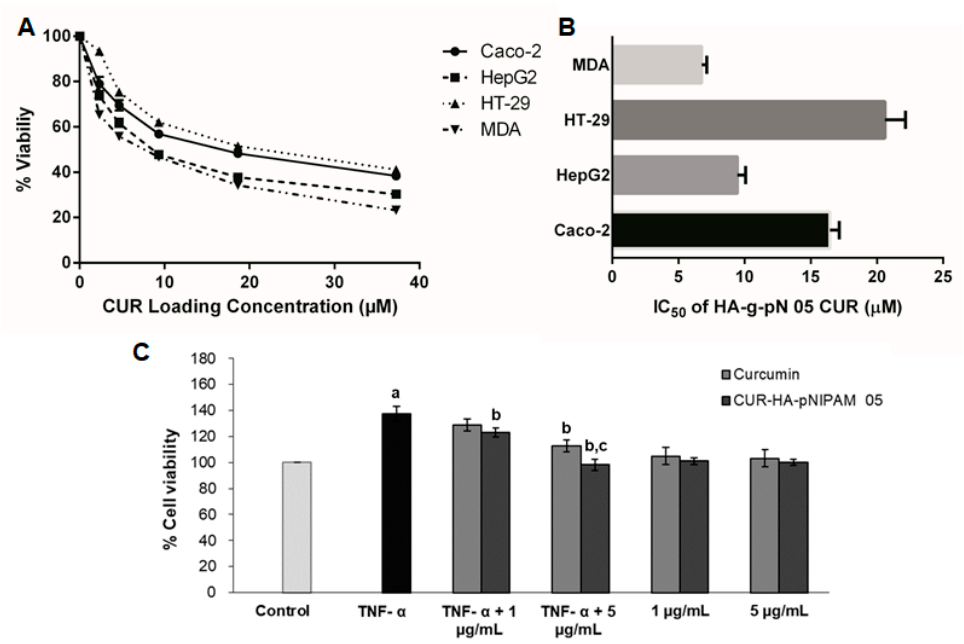
Figure 6. ( A ) The cell viability of four different cancer cell lines per increasing doses of curcumin in HA-pNIPAM 05 nanogel formulation. ( B ) IC 50 of curcumin encapsulated in the nanogel formulation against four different cancer cell lines; ( C ) the anti-proliferation assay of curcumin and CUR-HA-pNIPAM 05 (1 and 5 µg/mL) against TNF- α -induced HaCaT cell proliferation. Data presented are mean ± SD values of the four replications. a p < 0.05 indicates significant differences from the control group; b p < 0.05 indicates significant differences from the TNF- α group; c p < 0.05 indicates significant differences from the TNF- α + curcumin 5 µg/mL group.